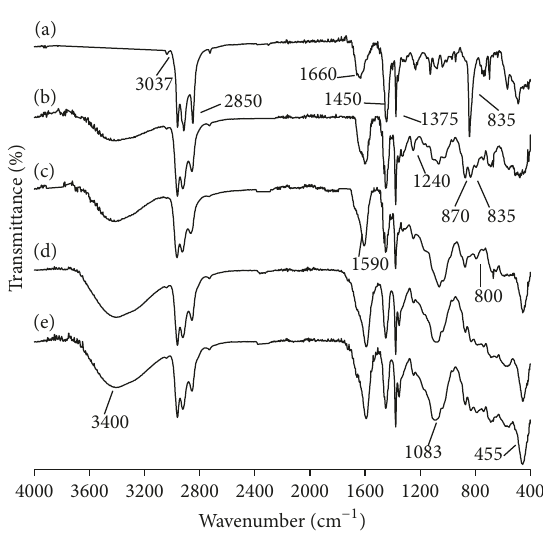
Figure 1: FTTR spectra of (a) NR, (b) ENR 40, and nanocomposites of (c) 100/1 ENR 40/nSiO 2 , (d) 100/2 ENR 40/nSiO 2 , and (e) 100/3 ENR 40/nSiO 2 .